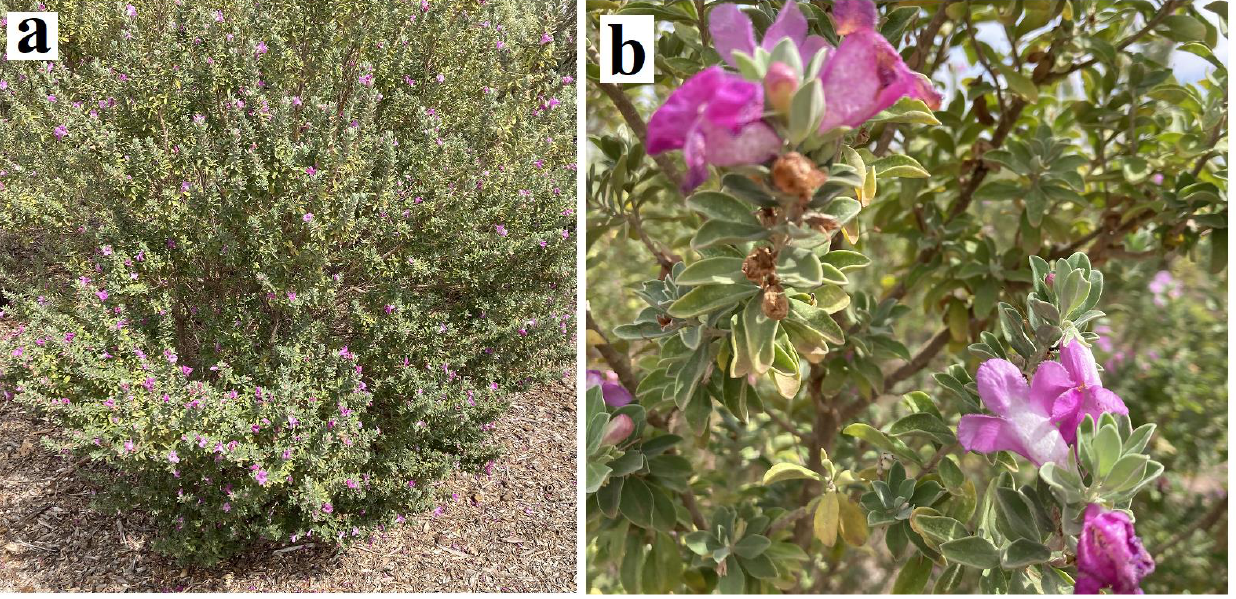
Figure 1. Eremophila maculata (Ker Gawl.) F.Muell. ( a ) whole plant and ( b ) leaves and flowers. Photograph was taken in the Australian Arid Lands Botanic Garden, Port Augusta, Australia, in January 2021 by Ian